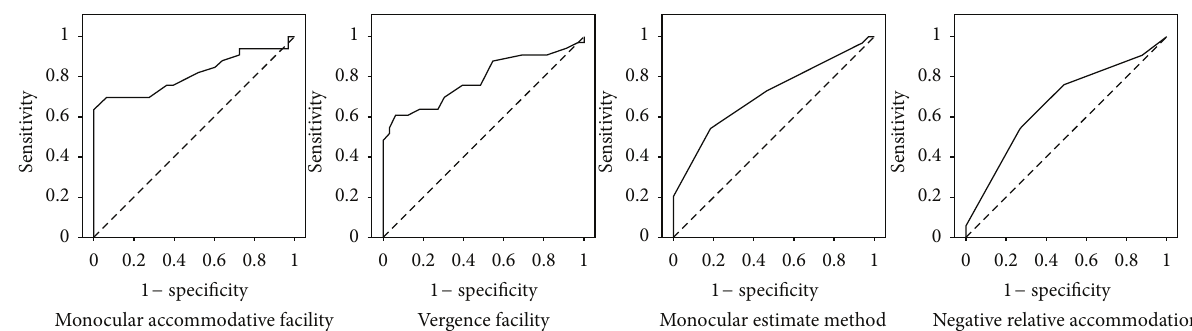
Figure 1: ROC curves for near point of convergence break and recovery, binocular accommodative facility, monocular accommodative facility, vergence facility, monocular estimate method and negative relative accommodation.